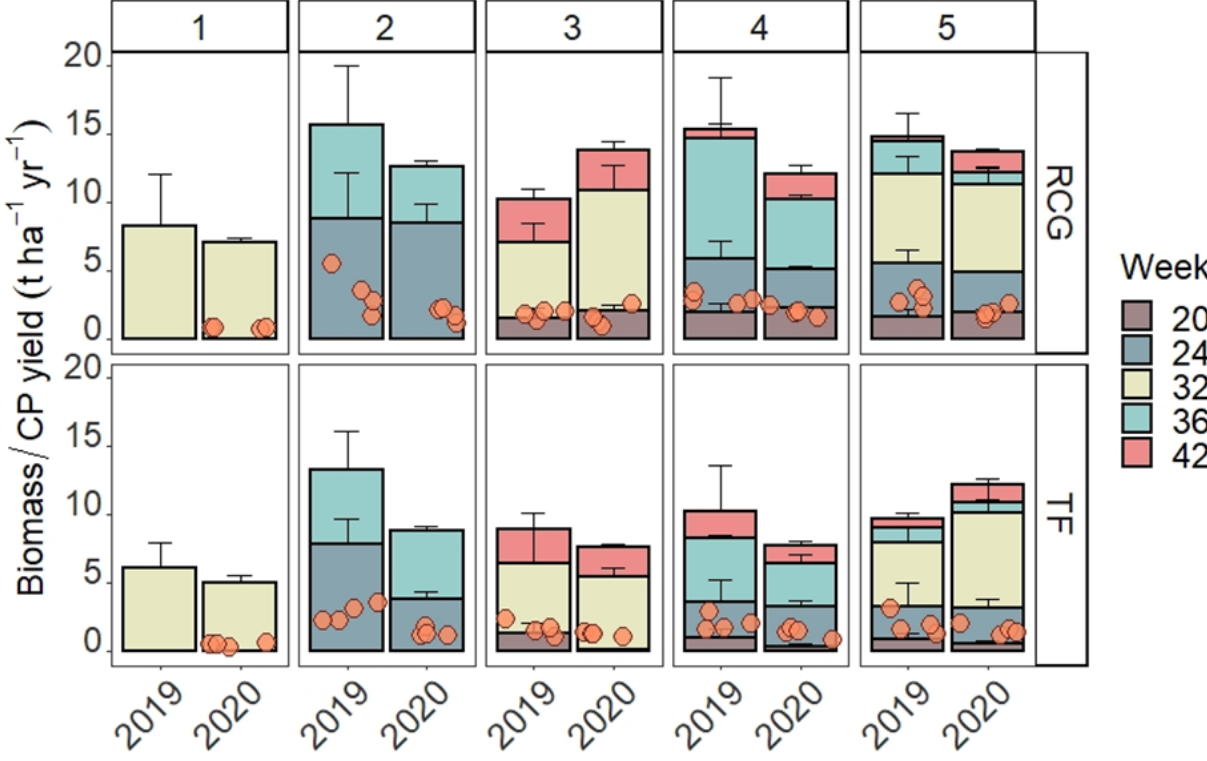
Figure 2. Cumulative annual yields of biomass (DM; columns) and crude protein (CP; dots), showing the mean contributions of different harvest occurrences (weeks) to the total. Error bars indicate the maximum deviation from the mean by showing the standard error. Compared horizontally, the panels (1 to 5) indicate treatments (different harvest frequencies), while vertically they show results for the two species Phalaris arundinacea (RCG) and Festuca arundinacea (TF). Data for 2019 were taken from Nielsen et al .